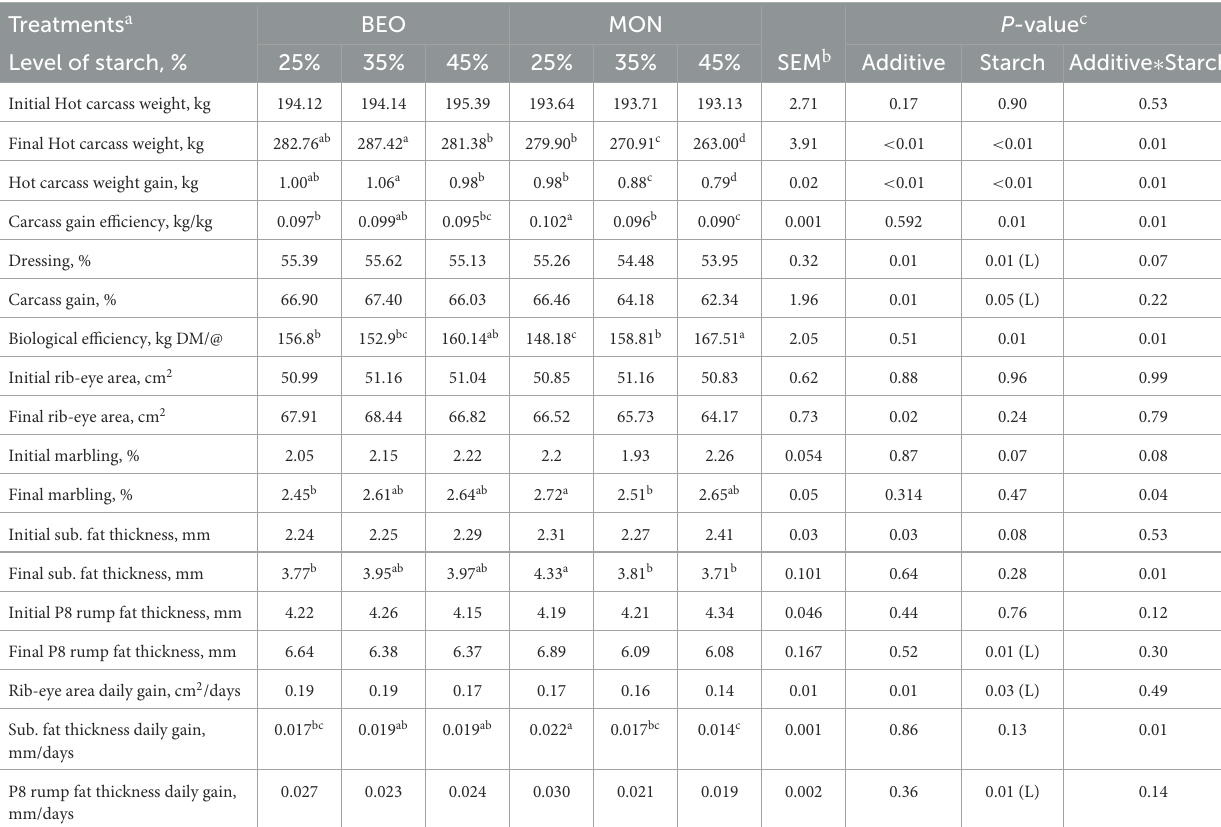
TABLE 3 Levels of starch associated with blend of essential oils or sodium monensin on carcass characteristics of Nellore yearling bulls. Treatments a BEO MON P- value c Level of starch, % 25% 35% 45% 25% 35% 45% SEM b Additive Starch Additive ∗ Starch Initial Hot carcass weight,